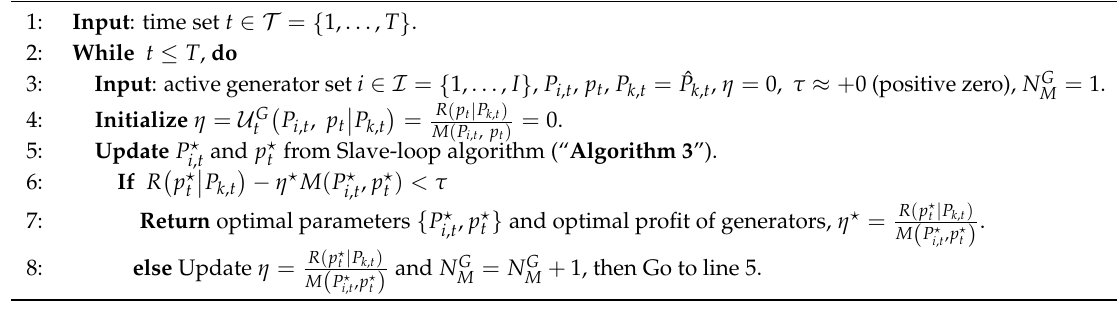
Algorithm 1. Generator’s Profit Maximization (lines 3–8, performed by the generator, master-loop algorithm).